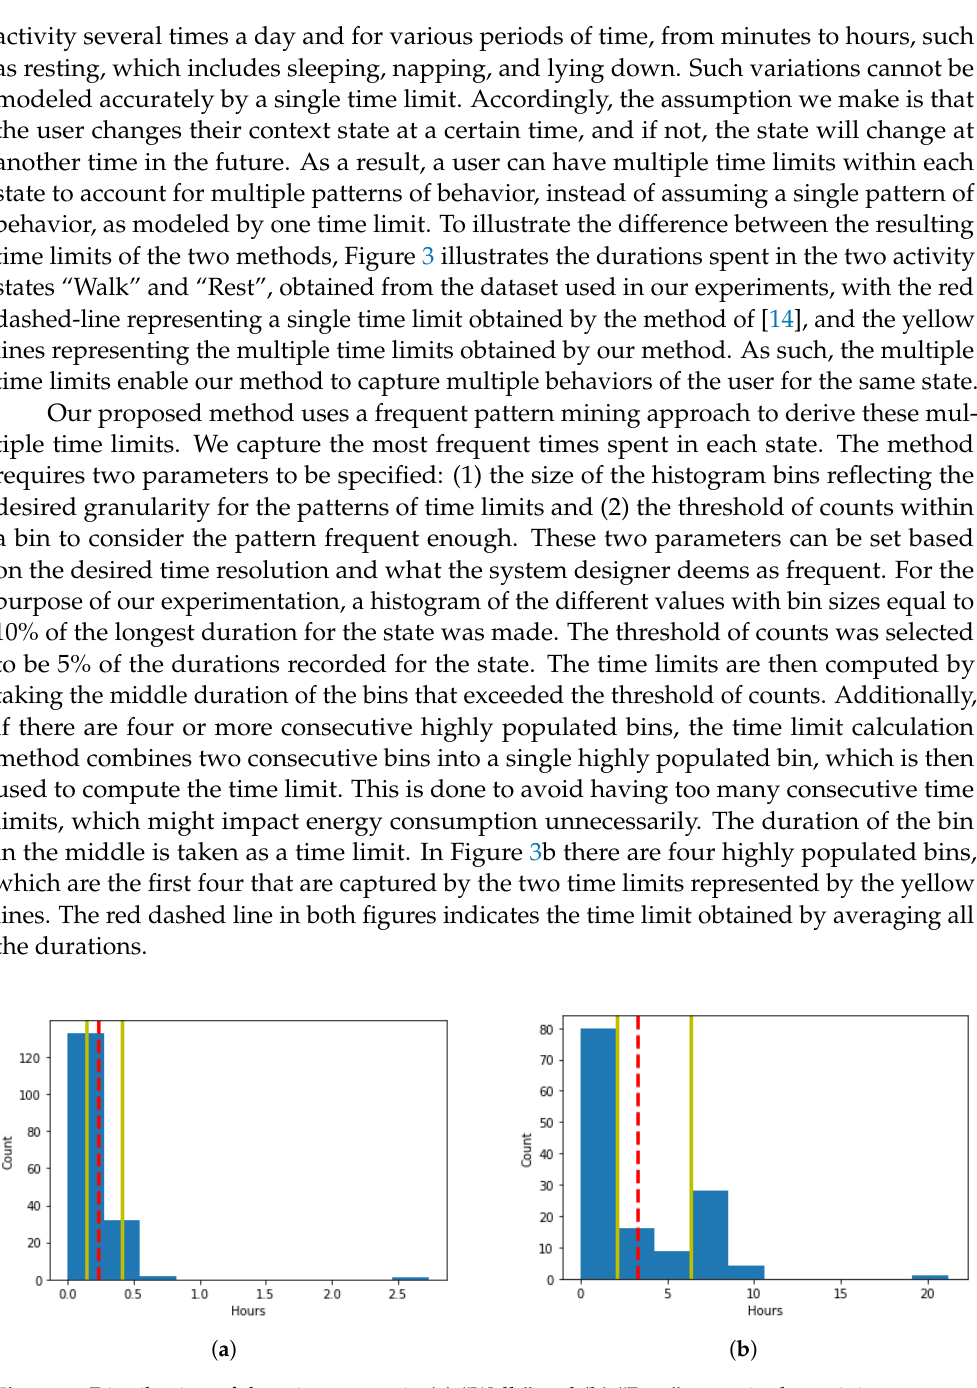
Figure 3. Distribution of durations spent in ( a ) “Walk” and ( b ) “Rest” states in the activity